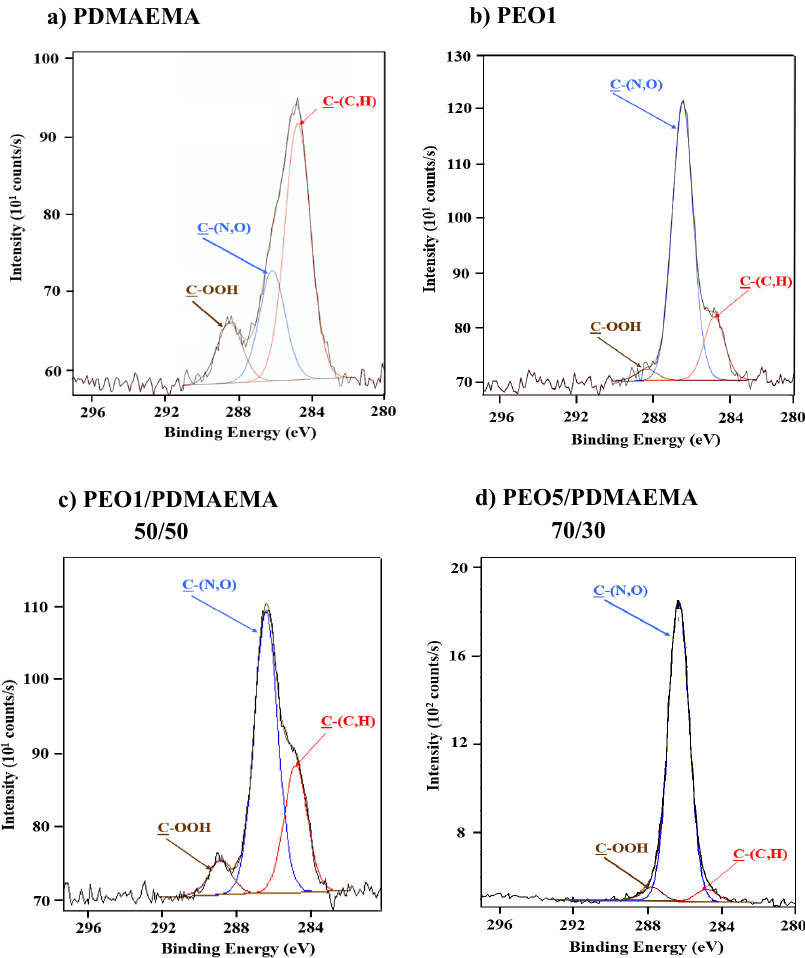
Figure 4. C 1s peaks recorded by XPS on gold surfaces modified with thiol-functionalized polymers: ( a ) PDMAEMA, ( b ) PEO 1, ( c ) PEO1 / PDMAEMA 50 / 50, ( d ) PEO1 / PDMAEMA 70 / 30. Peak decomposition was performed according to the protocol described in the Section